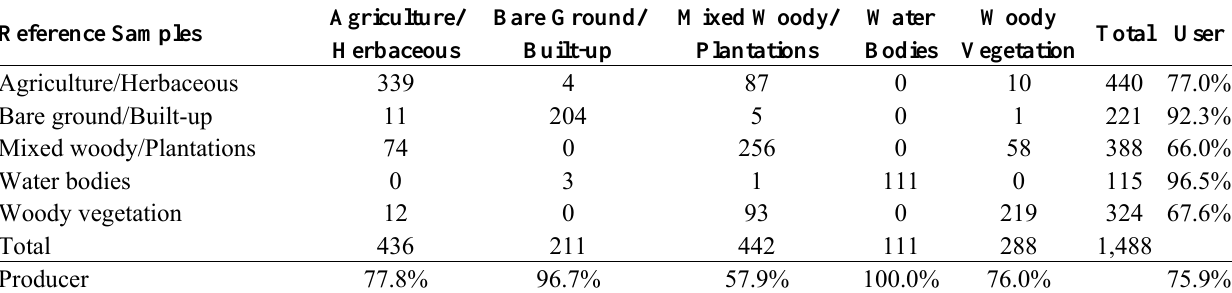
Table 2. Overall producer and user accuracies for the five-class land-cover